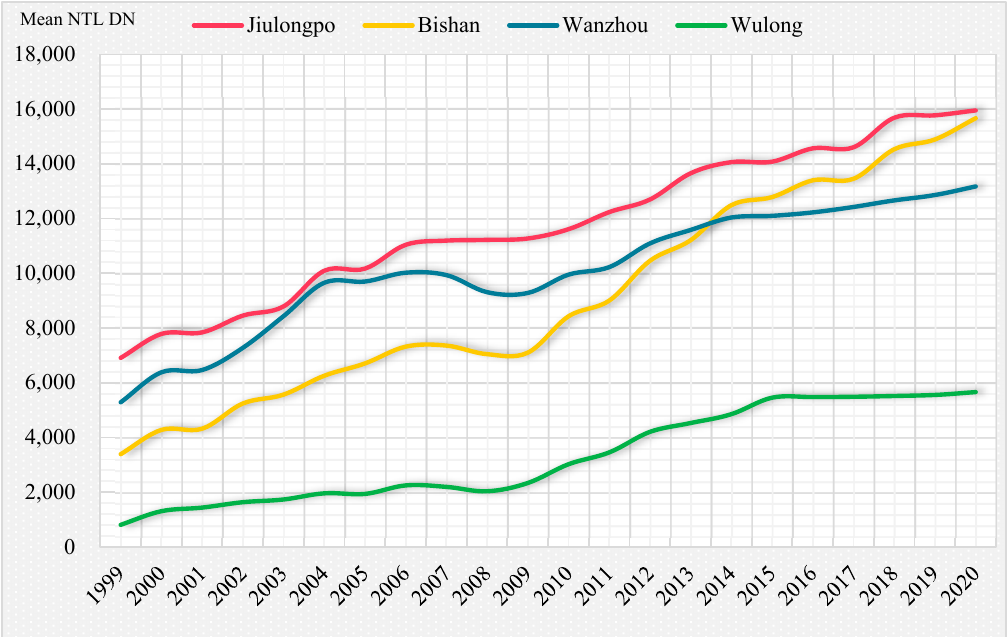
Figure 14. NTL sum from 1999 to 2020 for four suburban district zones.